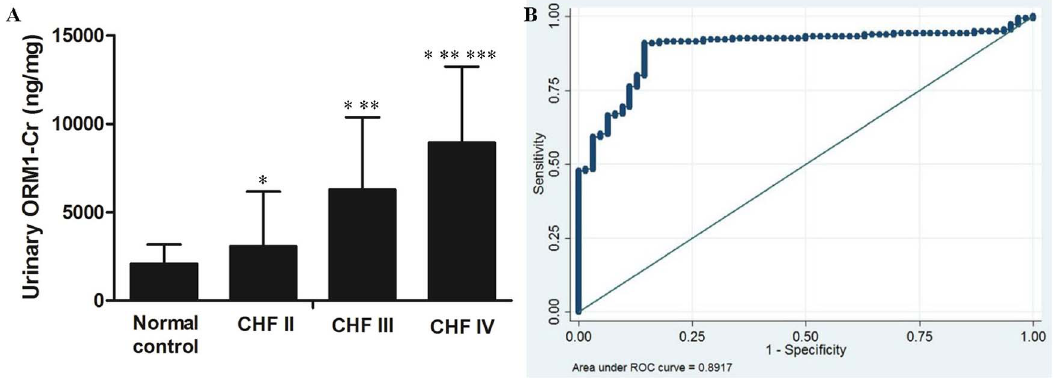
Figure 4. Urinary ORM1 as a potential biomarker for CHF. (A) ELISA was used to quantify urinary ORM1 levels in 176 patients with CHF and 62 healthy controls. The expression level of ORM1 in different NYHA functional classification of CHF. * P , 0.05 compared with control group; ** P , 0.05 compared with CHF I; *** P , 0.05 compared with CHF III. (B) ROC curve of urinary ORM1 as a detection marker for CHF was based on a series of 238 urine samples. The optimal cut off was 2484.98 ng/mg, and the area under the ROC curve (AUC) for diagnosis of CHF was 0.892 (95% confidence interval (CI) 0.848–0.936).